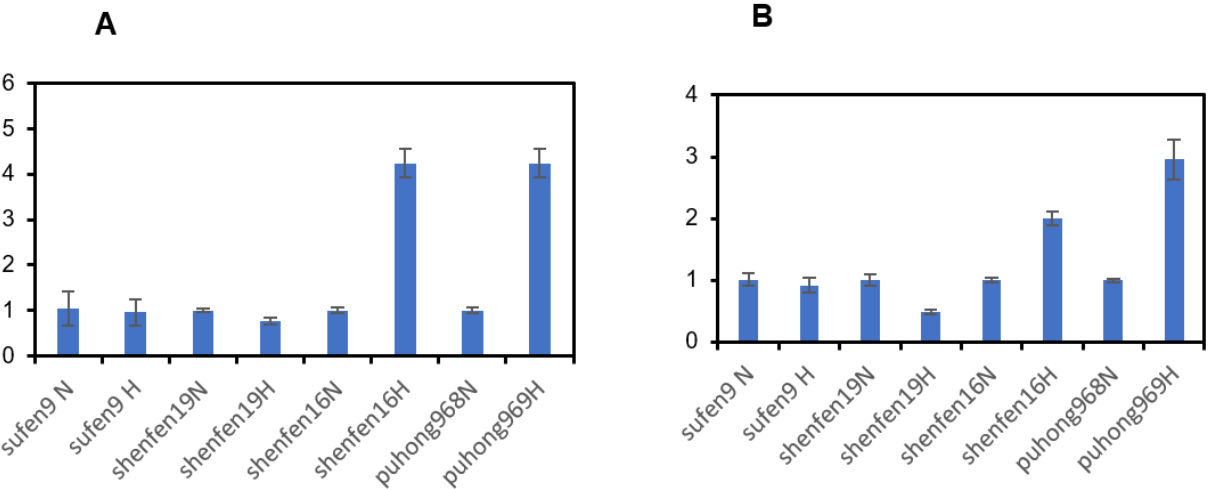
Figure 10. MYC ( A ) and JA ( B ) activation in different types of samples. Note: NT, normal growth condition under 25/18 °C and water; NS, normal growth condition under 25/18 °C with 1 mM Spd treatment on plants; HT, high temperature growth condition on 38/28 °C and water treatment; HS, high temperature growth condition on 38/28 °C with 1 mM Spd treatment on leaves.